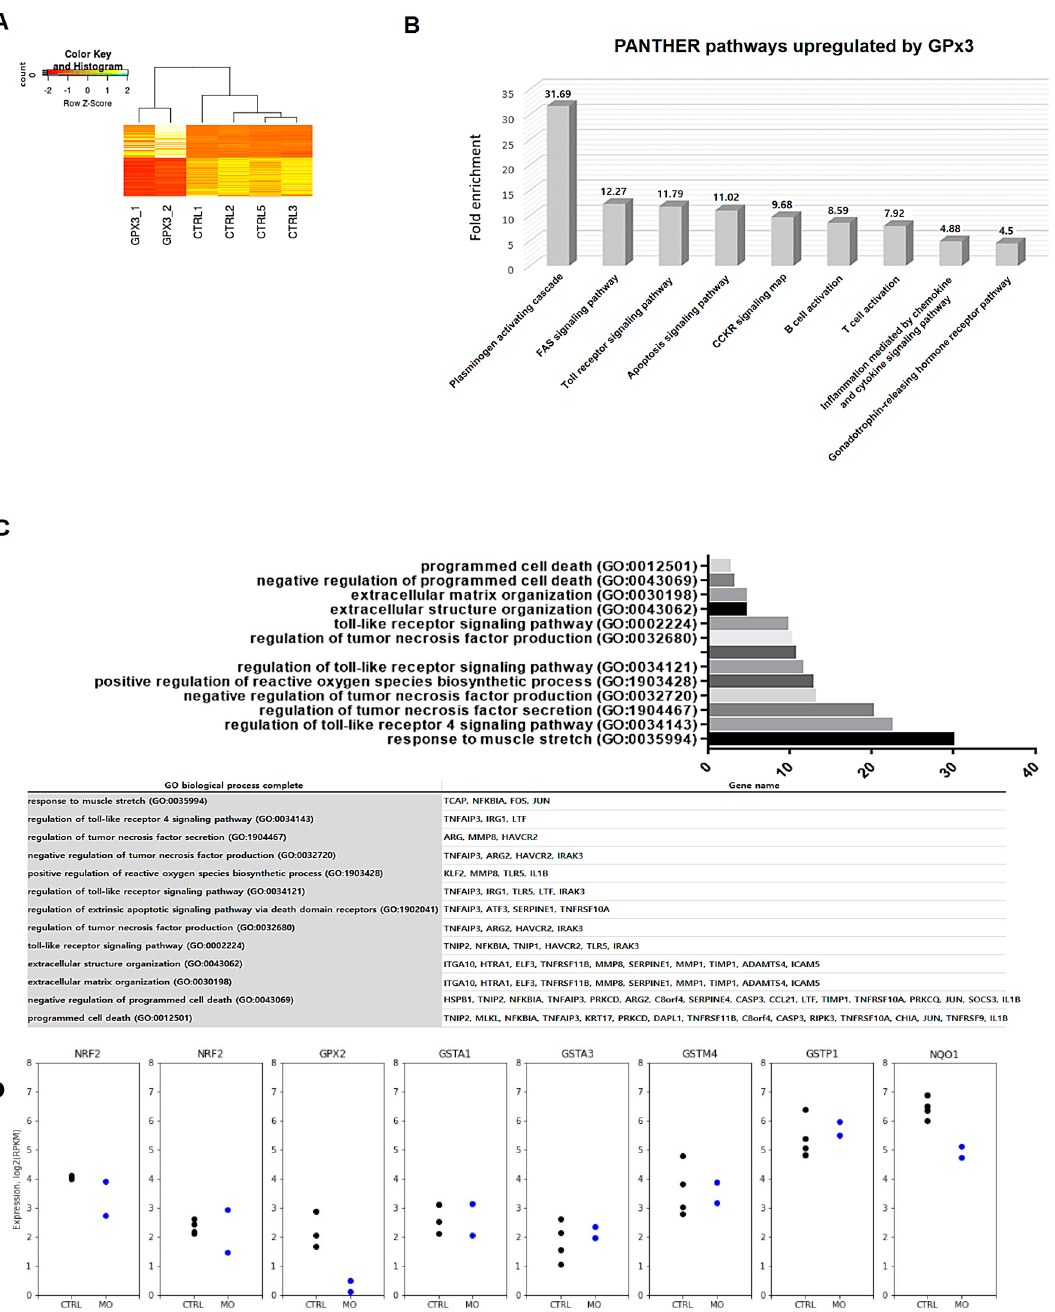
Figure 4. E ff ects of gpx3 knockdown on the Xenopus embryo transcriptome. ( A ) Heat map showing significant di ff erences between control and gpx3 MO-injected embryos. ( B ) Transcriptome enrichment analysis using PANTHER indicated that cell death processes are significantly upregulated in gpx3 -depleted embryos. ( C ) Gene ontology (GO-terms) and genes also indicated that genes associated with apoptosis and cell-death-related pathways were significantly a ff ected by gpx3 depletion. ( D ) The expression of Nrf2 and its putative targets were not a ff ected by gpx3 knockdown.